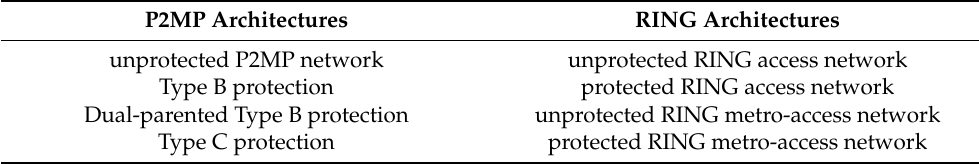
Table 1. Summary of considered presumptive scenarios for WDM-PON protection